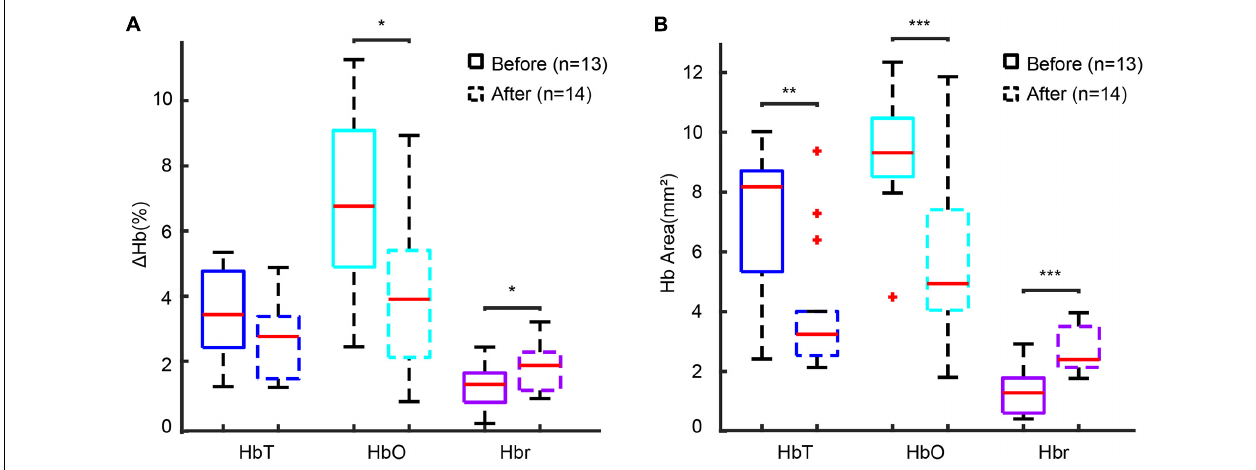
FIGURE 6 | Disruption of endothelial reactivity recapitulates the effect of anesthesia. (A) Box plot of hemodynamic amplitude change-induced before and after endothelial disruption with photo-activation of FITC-dx. (B) Box plot of the hemodynamic area before and after endothelial disruption with photo-activation of FITC-dx. *** p < 0.001, ** p < 0.01, and * p <